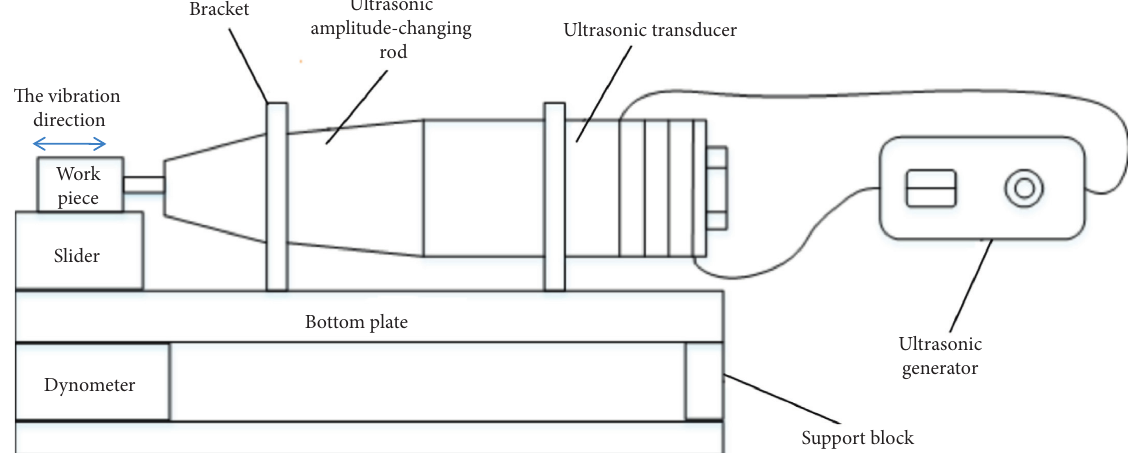
Figure 4: Schematic diagram of the ultrasonic vibration system.